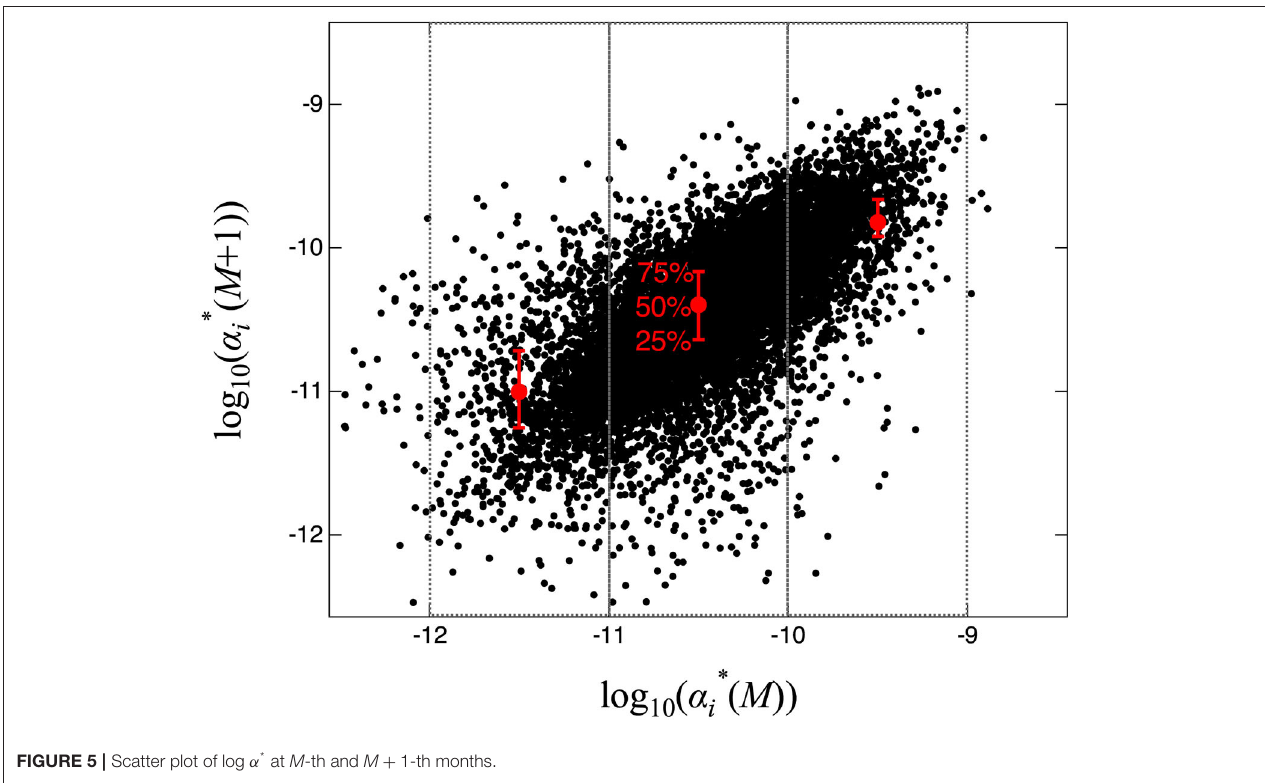
FIGURE 5 | Scatter plot of log α * at M -th and M + 1-th months.